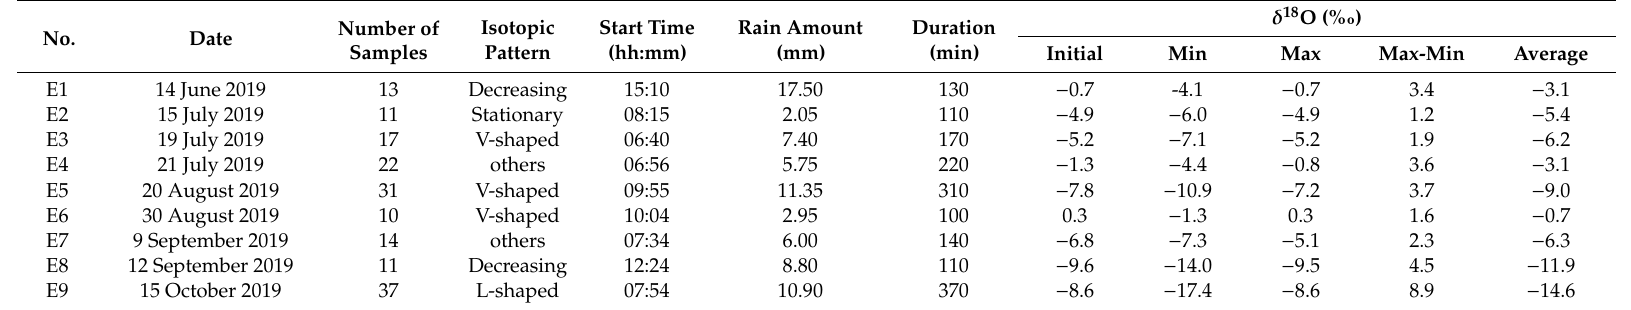
Table 1. Sampling information of the precipitation, and the variation of δ 18 O from the intra-events in